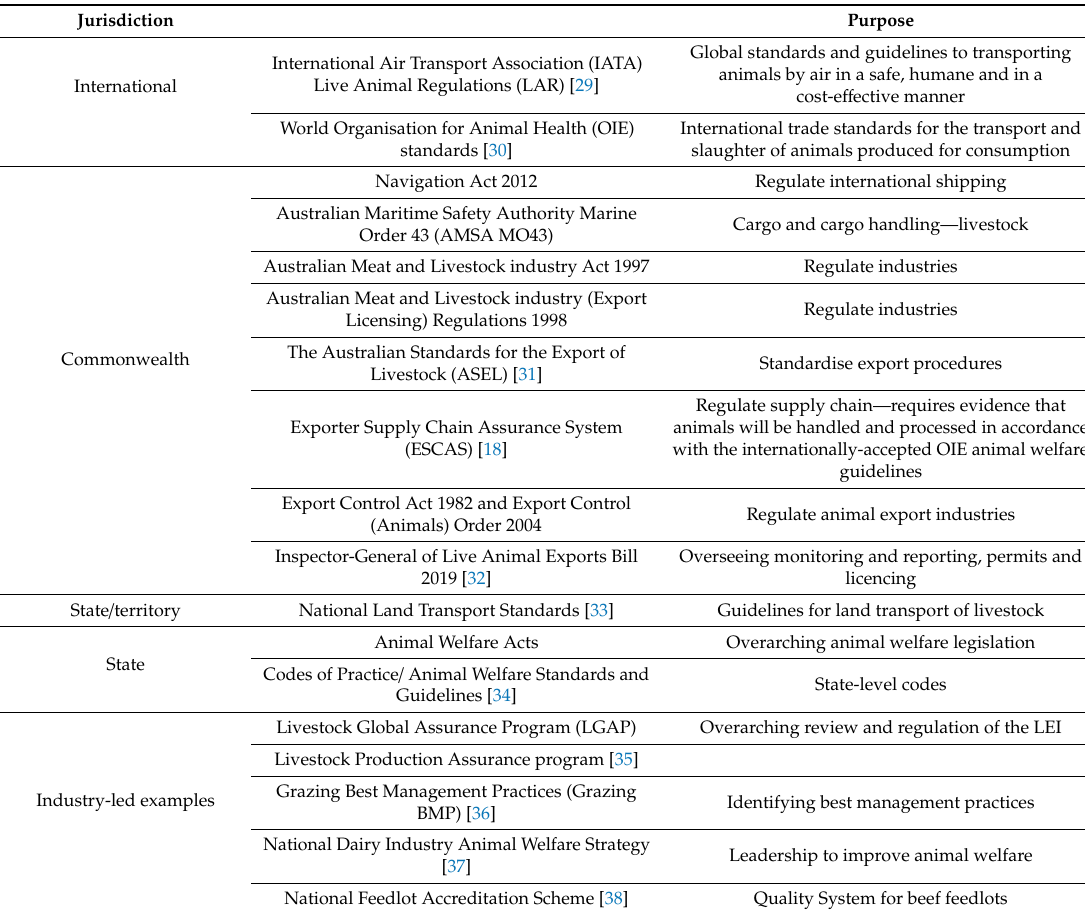
Table 2. Laws or regulations that are relevant to the live export industry. Included are examples of government and industry-led management